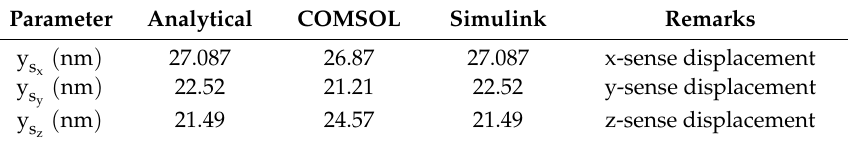
Figure 10. Sense-mode analysis of the proposed single-drive, 3-axis MEMS gyroscope using Matlab/Simulink. Table 9. Sense-displacement comparison of the proposed single-drive, 3-axis MEMS gyroscope. Parameter Analytical COMSOL Simulink